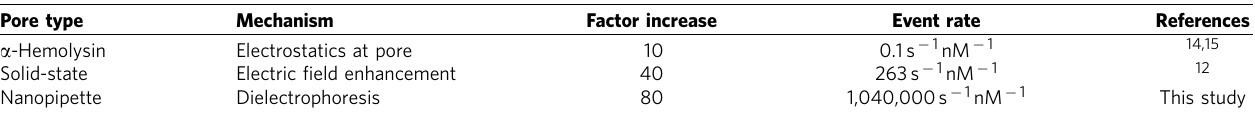
Table 1 | Comparison between methods to control capture